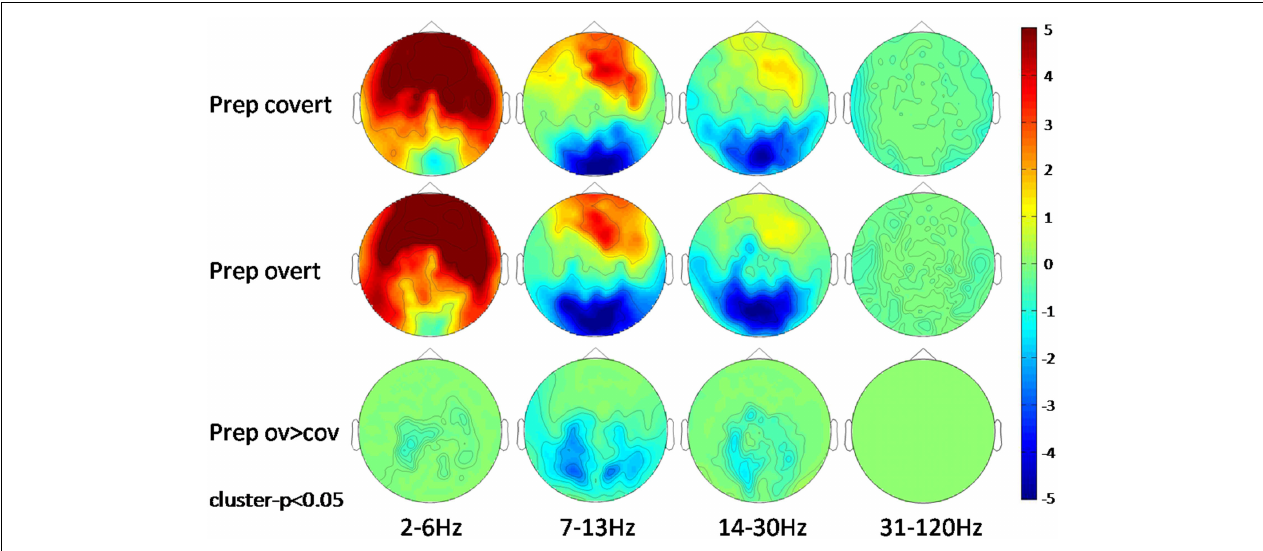
FIGURE 3 | Scalp-frequency plots of the first second of the preparation (Prep) period for covert and overt speech production vs. baseline and for preparation for overt vs. preparation for covert speech production. Pseudo t -values are color-coded from − 5 to 5. Results are cluster corrected ( p < 0.05).